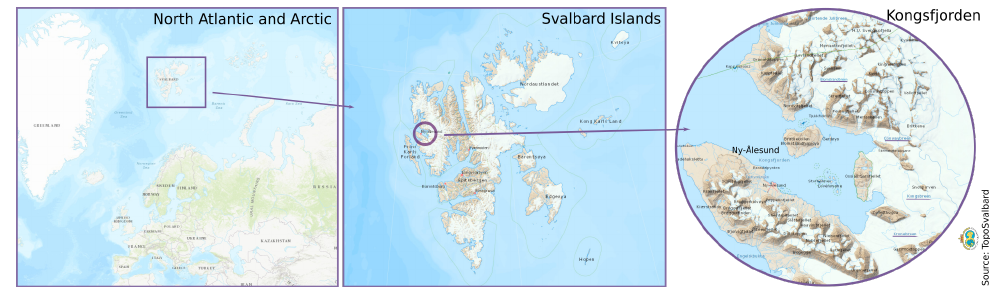
Figure 2. The location of Svalbard and